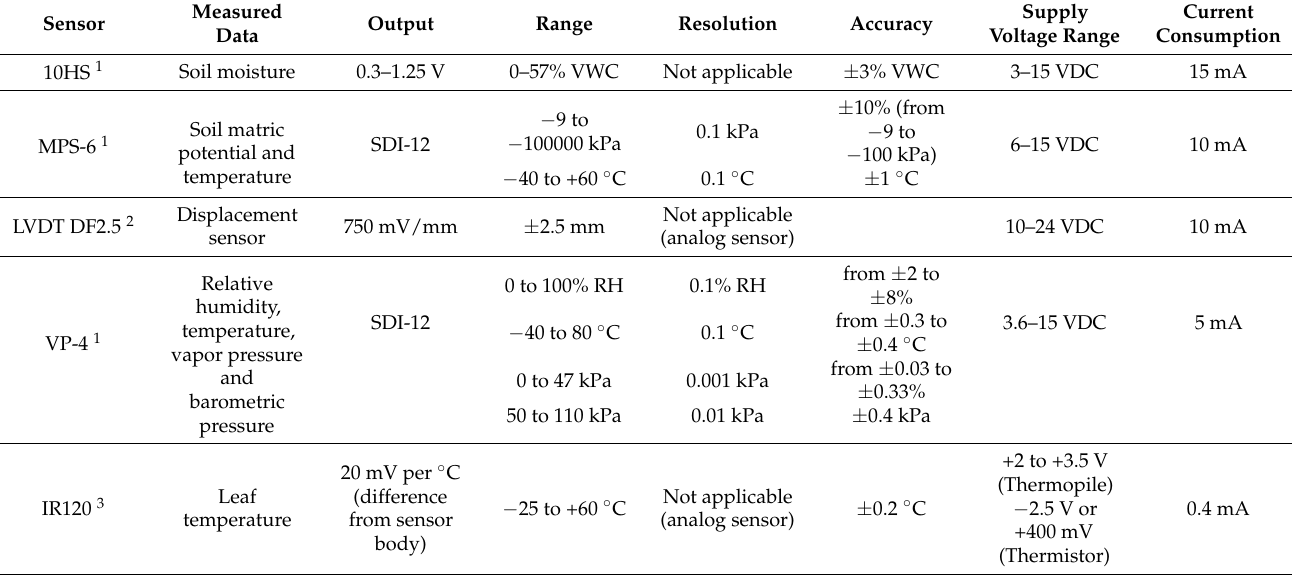
Table 1. Overview of the sensors used in the